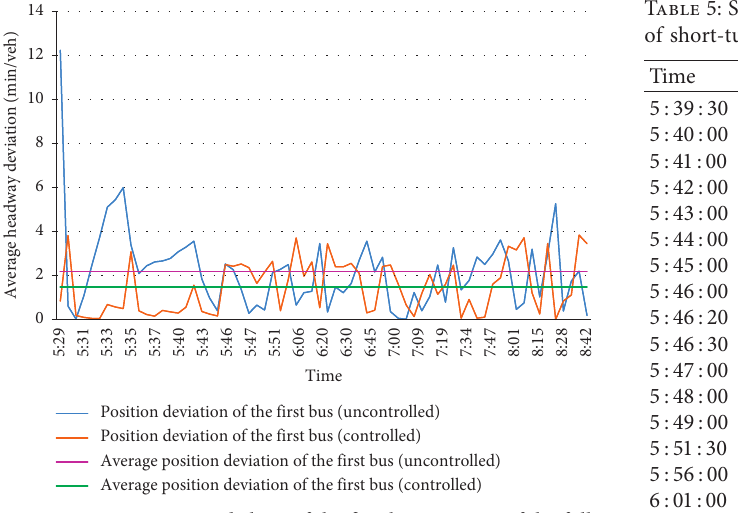
Figure 6: Deviation trend chart of the first bus position of the full- length bus under controlled and uncontrolled conditions.